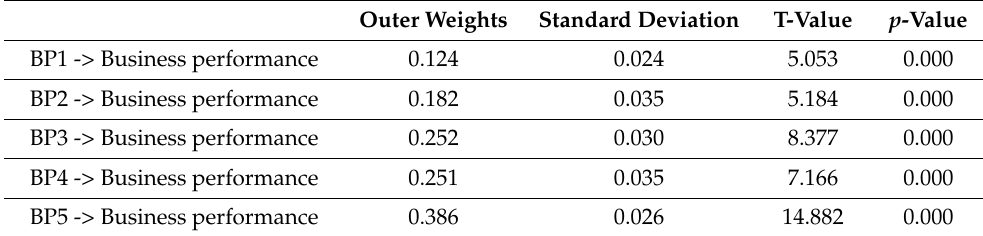
Table 6. Statistical analysis of formative measurement